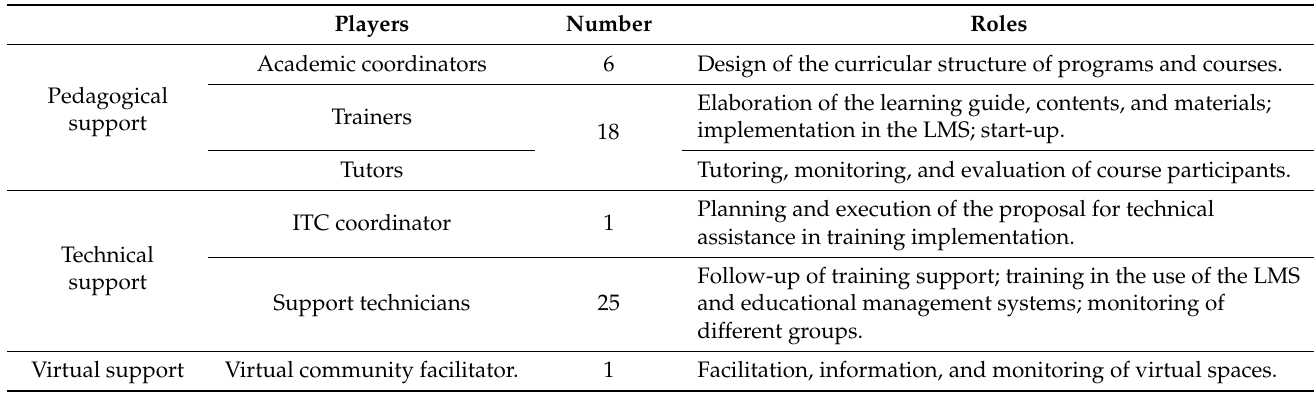
Table 3. Key players in the training process and their